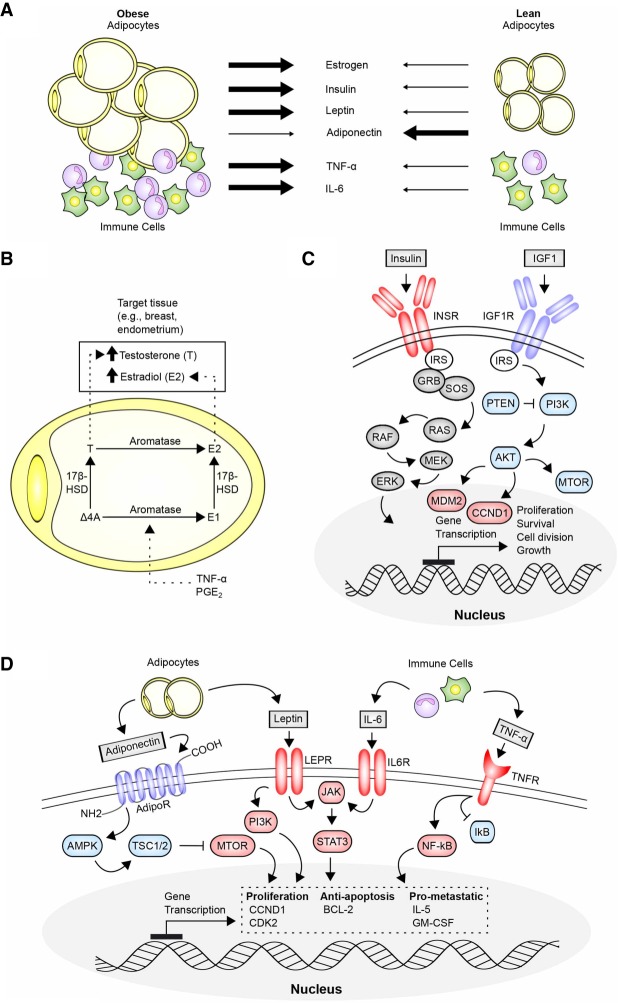
Cancer related molecular mechanisms driven by obesity. (A) Obesity causes formation of an expanded compartment of fat-storing cells (adipocytes) and accumulation and activation of immune cells. Signaling from these cells is commonly associated with an increase in TNF-α and IL-6 activity, two important regulators of cell proliferation and inflammation, and is related to immune cell activation. Obesity is also associated with an increase in the level of hormones, such as estrogen, insulin, and leptin, and a decrease in adiponectin, an important negative regulator of metabolism. (B) Excess adipocyte activity increases levels of bioavailable testosterone (T) and estradiol (E2) throughout the body. Within adipocytes, androstenedione (Δ-4A) is modified to testosterone by 17β-hydroxysteroid dehydrogenases (17β-HSD) or to estrone (E1) by aromatase (an enzyme also known as estrogen synthetase). In obesity, elevated aromatase expression is facilitated in part by increased levels of prostaglandin (PGE2) and TNF-α. In certain tissues (e.g., breast and endometrium), high levels of testosterone and estradiol have been associated with cancer growth and survival. (C) Obesity elevates levels of insulin and IGF1, which bind receptors (INSR and IGF1R) expressed on tumor cells to activate core signaling cascades mediated by RAS and PI3K–AKT–MTOR that strongly drive cell proliferation and survival. (D) In the obese state, low levels of adiponectin reduce activity of AMP kinase (AMPK), a strong regulator of metabolic activity, particularly relevant in terms of the regulation of MTOR. At low levels of adiponectin, MTOR activity contributes to increased cell proliferation, anti-apoptotic activity, and expression of prometastatic genes. Adipocyte-produced leptin and immune cell-produced IL-6 activate JAK–STAT3 signaling to promote cell proliferation and survival. TNF-α inhibits the negative NF-kB regulator IkB, freeing NF-kB to further support a progrowth state.